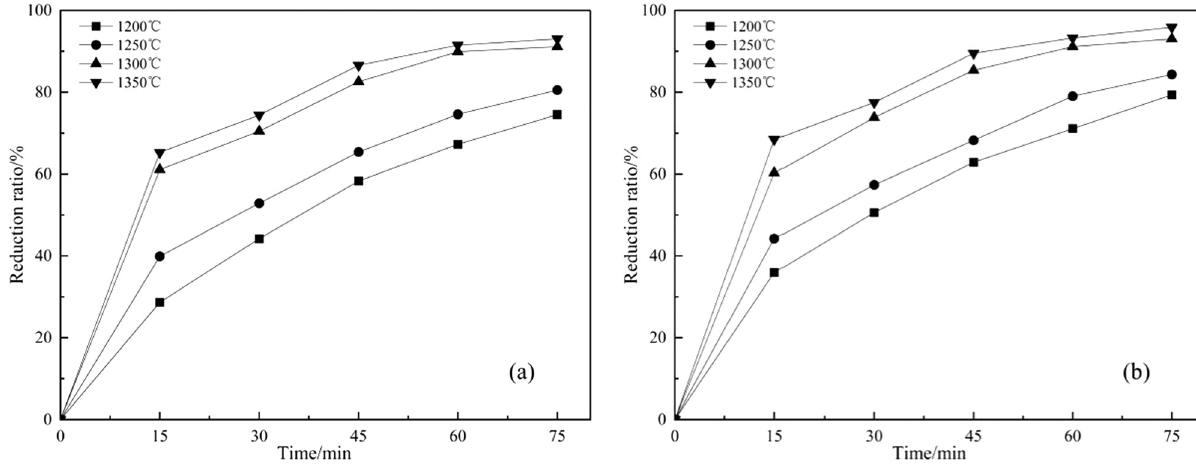
Figure 5: Relationship between the reduction rate containing SiO 2 ( a ) and fl y ash ( b ) at di ff erent reaction time and temperatures.